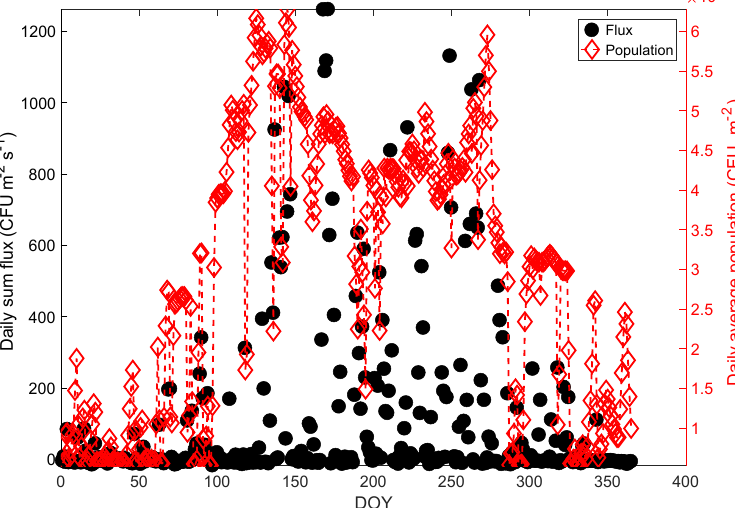
Figure 9. Time series of the daily sum of modeled microbial fluxes and daily averages of the surface microbial population for 2015. The labels on the x axis define the DOY starting from 1 January 2015 (DOY 1, Northern Hemisphere winter) to 31 December 2015 (DOY 365, Northern Hemisphere winter).